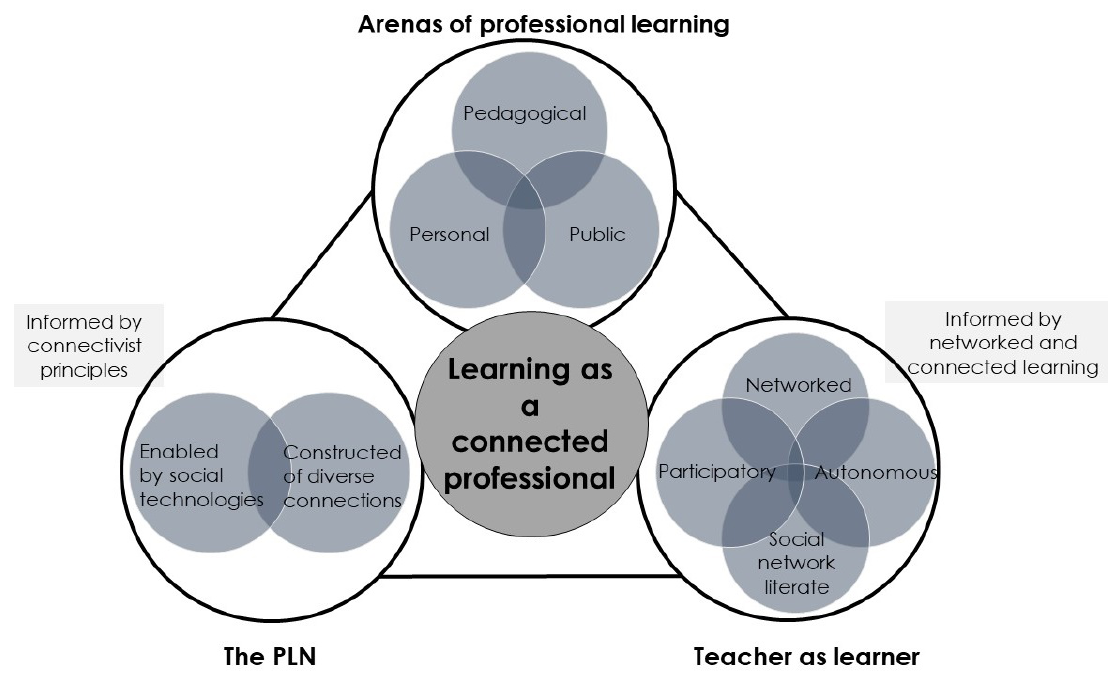
Figure 1. Learning as a connected professional